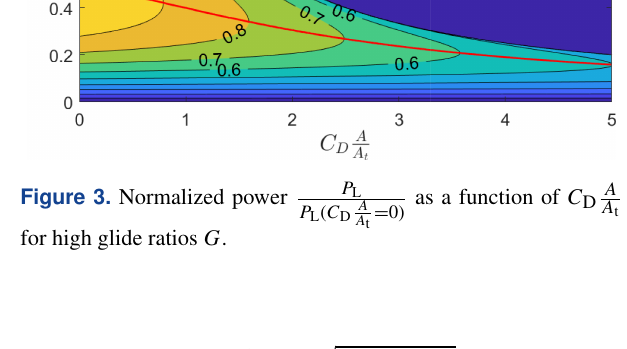
Figure 3. Normalized power P L for high glide ratios G